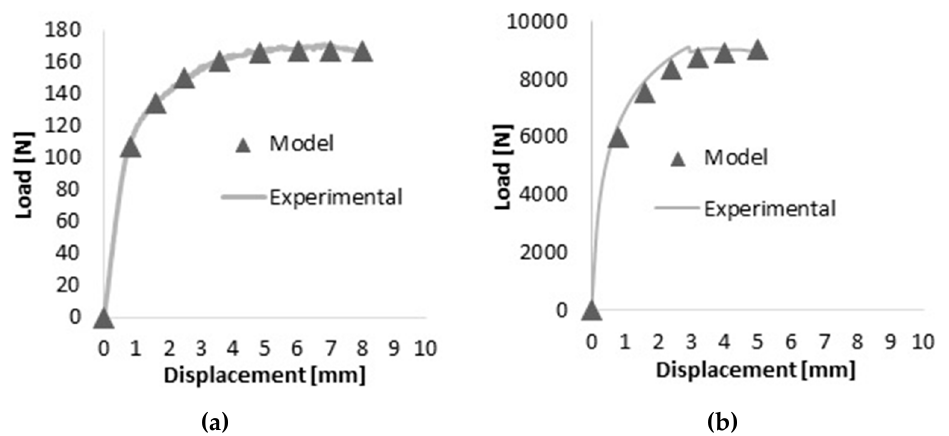
Figure 4. Experimental and predicted bending force-displacement curves of ( a ) DP1 and ( b ) DP2 steels. YS: Yield Strength; UTS: Ultimate Tensile Strength; K and n are the Hollomon’s parameters; %m / %f is the ratio between martensite percentage and ferrite